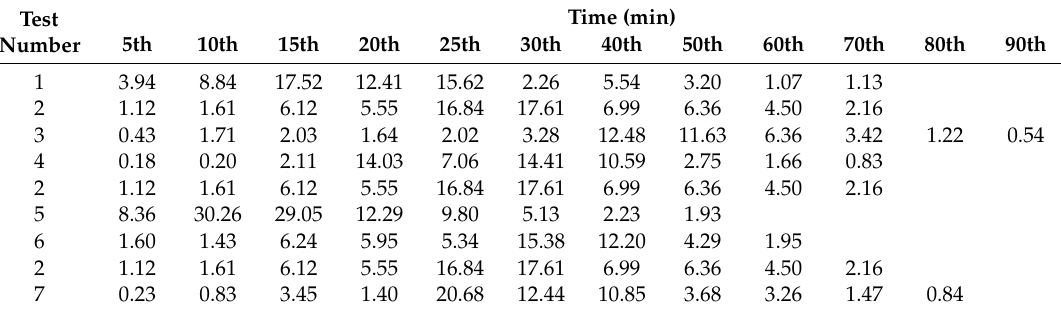
Table 4. Variation of sands erosion rate with time (kg /